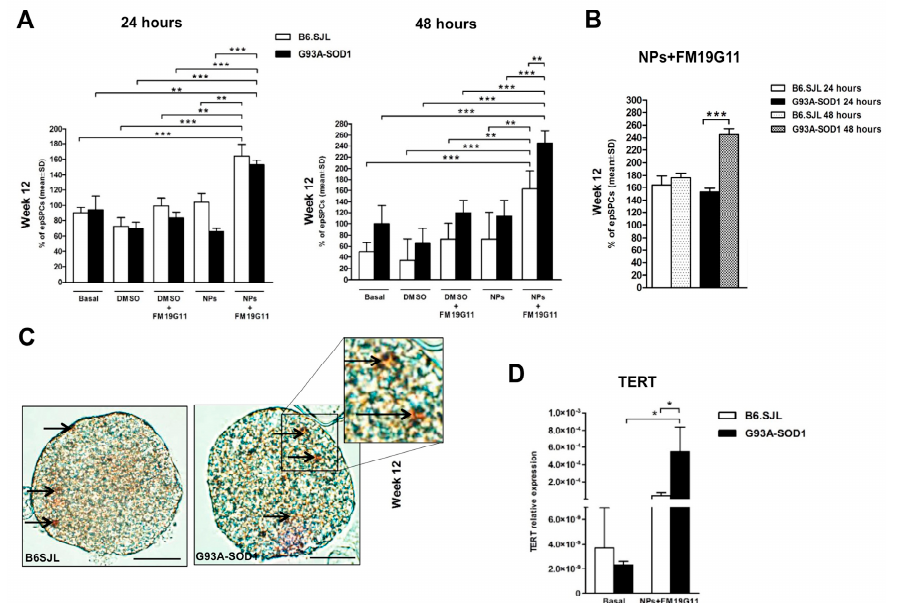
Figure 1. Effect of FM19G11 treatment on the percentage of G93A-SOD1 and control B6.SJL ependymal stem progenitor cells (epSPCs) and telomerase reverse transcriptase ( TERT ) expression. ( A ) Percentage of 12-week B6.SJL (white bars) and G93A-SOD1 (black bars) epSPCs after 24 and 48 h in the following growth conditions: (1) growth medium alone as the basal control condition; (2) FM19G11 treatment and, separately, DMSO alone as vehicle control; and (3) FM19G11-loaded nanoparticle (NP) treatment and, separately, non-loaded NPs as control. ( B ) Percentage of B6.SJL and G93A-SOD1 epSPCs following 24 (white and black bars) and 48 (white and black dot patterns) hours of treatment with FM19G11-loaded NPs. Data presented as mean ± SD of epSPC percentage ( n = 10 different cell cultures from 10 animals per group). ( C ) Bright light microscopy images of B6.SJL and G93A-SOD1 epSPC neurospheres treated with BODYPY-labelled NPs. Arrows indicate NPs within cells, with higher magnification displayed in the inset. Scale bars: 20 µ m. ( D ) qRT PCR expression analysis of the TERT gene in B6.SJL (white bars) and G93A-SOD1 (black bars) epSPCs after 48 h of treatment with FM19G11-loaded NPs compared with basal conditions. Expression levels are reported as mean ± SD of 2 − ∆ CT values normalized against the endogenous control 18S ( n = 5 different primary cell cultures from five animals per group). * p < 0.05, ** p < 0.01, *** p < 0.001 by ANOVA followed by Bonferroni post-hoc